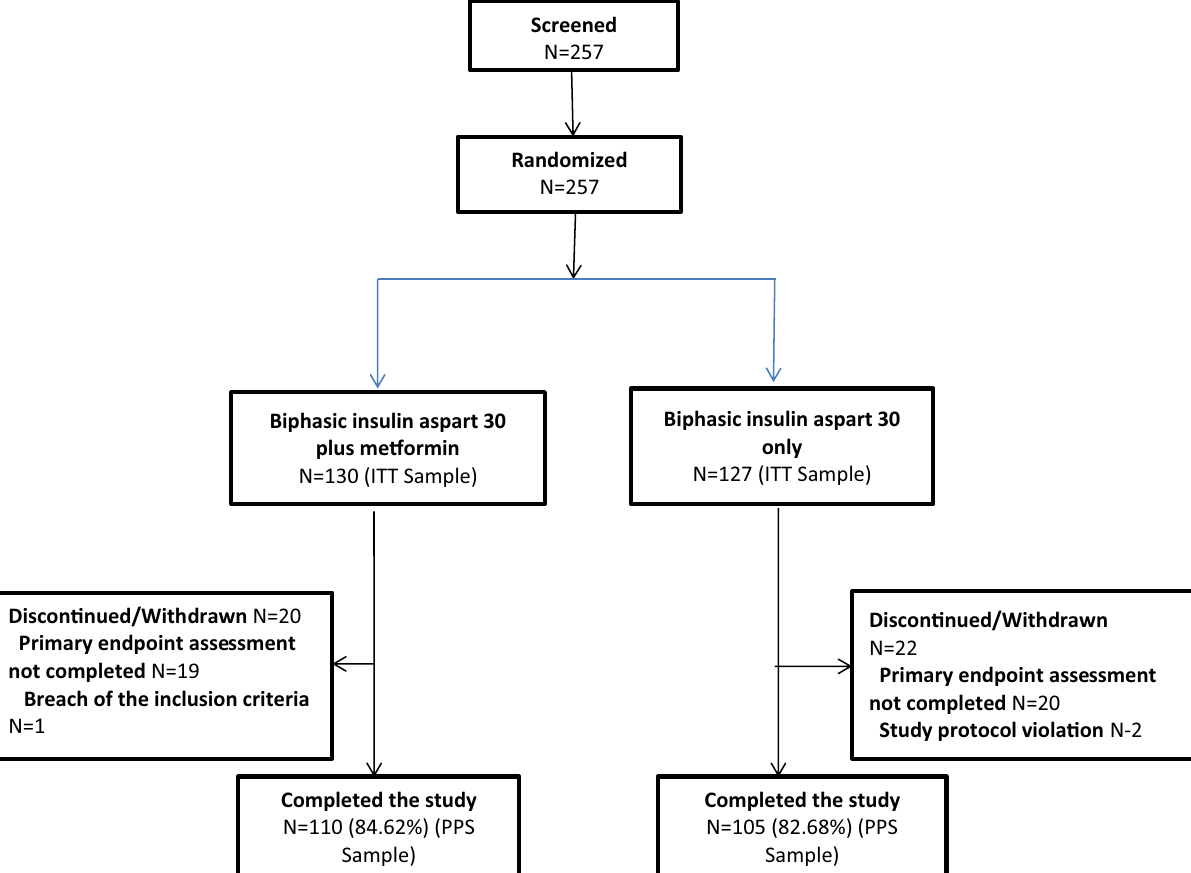
Figure 1. Flow diagram of the MERIT study. ITT, intent-to treat (created using Microsoft Word 2010, https :// www.micro soft.com/en-us/micro soft-365/previ ous-versi ons/micro